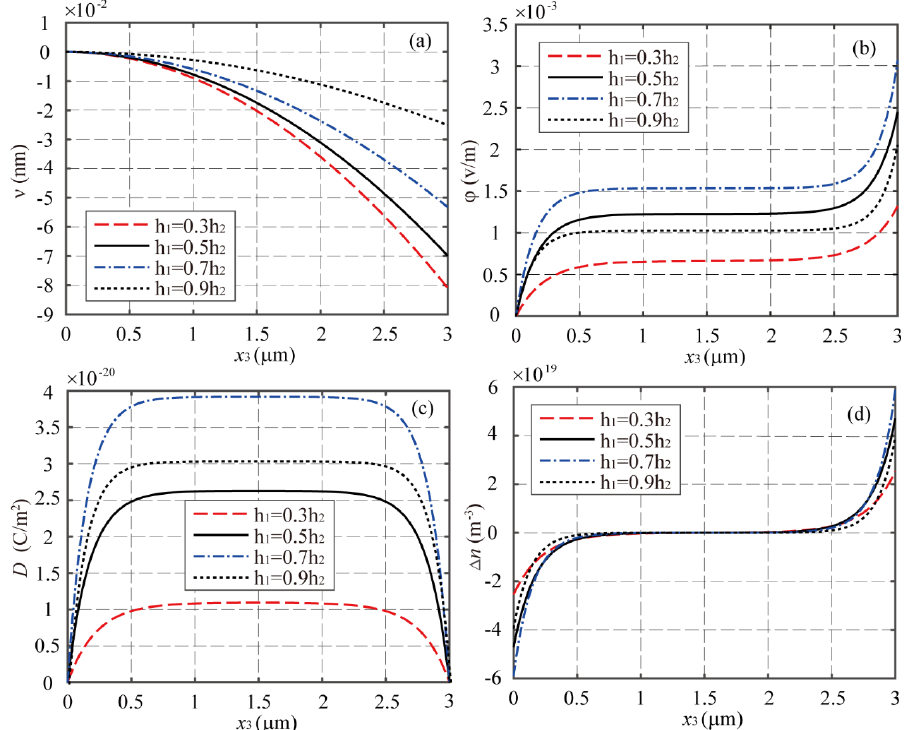
Figure 3. The values of ( a ) v , ( b ) ϕ , ( c ) ∆ n , and ( d ) ∆ n / n 0 at x 3 = L of the LMPS beam with n 0 = 10 21 m − 3 under different magnetic fields.